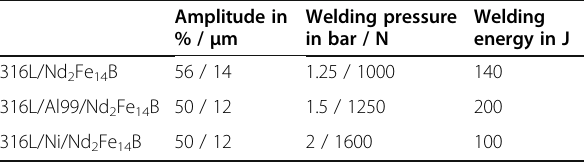
Table 2 Process parameter sets for the ultrasonically welded hybrid material systems